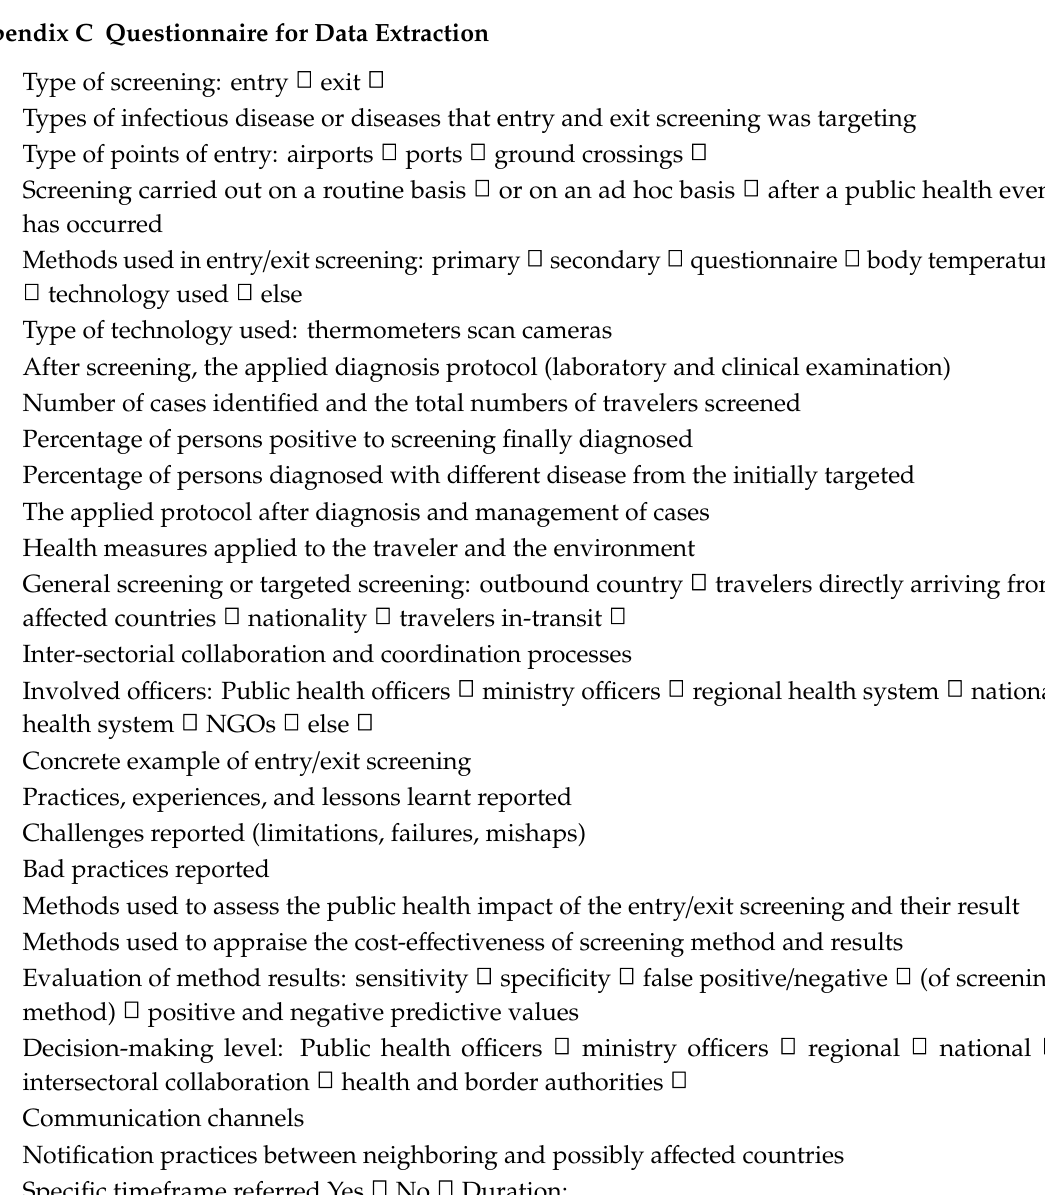
Appendix 2: Questionnaire for checking on eligibility criteria